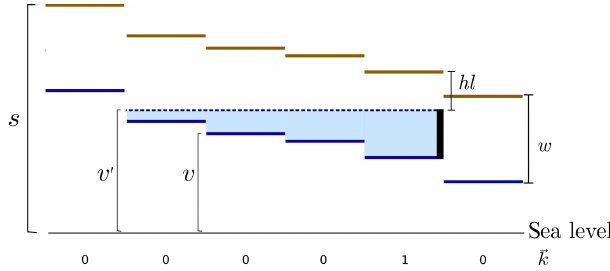
Figure 2. (a) DEM (colored) with the canal network superposed (white), (b) peat types and (c) peat depth. The resolution of the rasters is 100m × 100m.